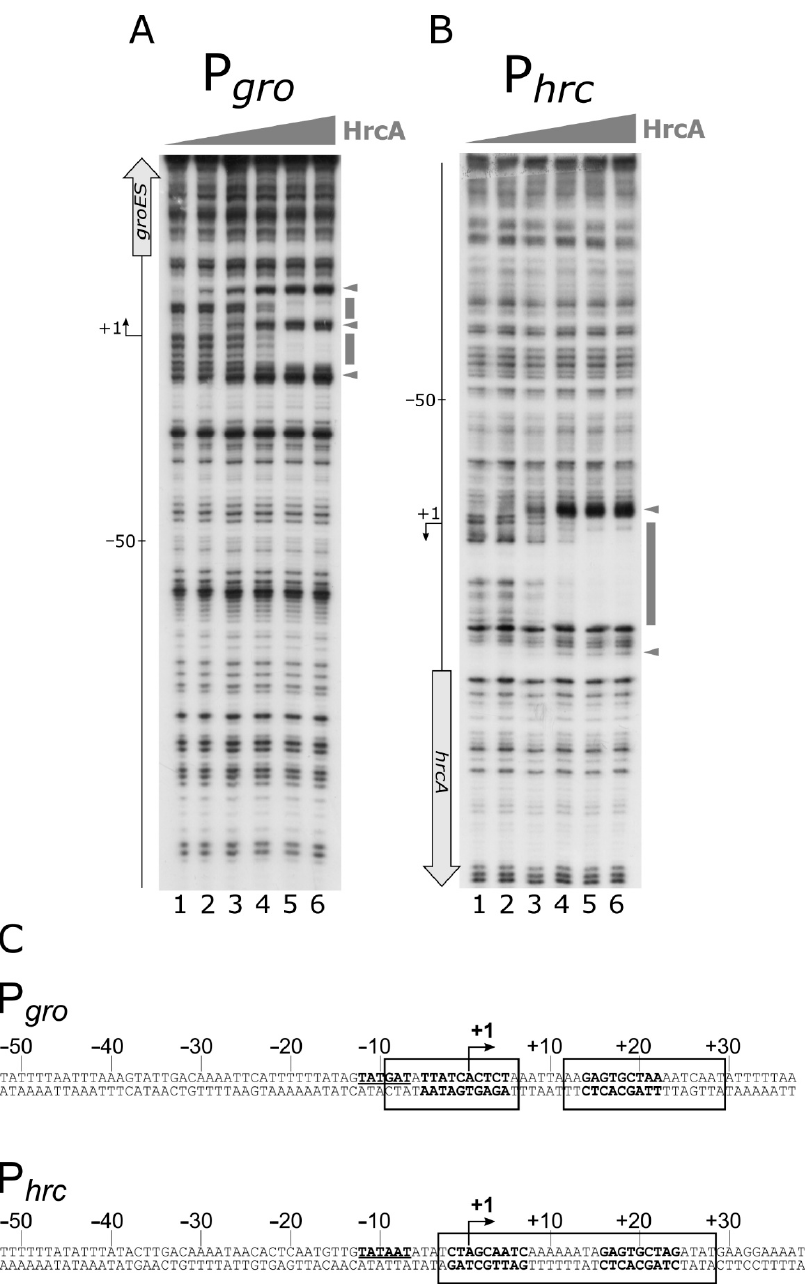
Figure 5. High ‐ resolution mapping of HrcA binding sites on P gro and P hrc promoters. Panel A and B : DNase I footprintings of HrcA on P gro and P hrc promoters, respectively. The radiolabeled probes were incubated with increasing concentrations of recombinant HrcA protein (0, 22, 45, 90, 180 and 360 nM HrcA; lanes 1 to 6, respectively), followed by partial DNase I digestion. The symbols are the same as in Figure 3. Panel C : hallmarks of the P gro and the P hrc promoter sequences. In detail, num ‐ bers refer to the transcriptional start site (+1). The − 10 box is underlined bold on the coding strands, and the CIRCE sequences are represented in boldface on both strands. Regions protected from DNase I digestion are enclosed in solid line open boxes.